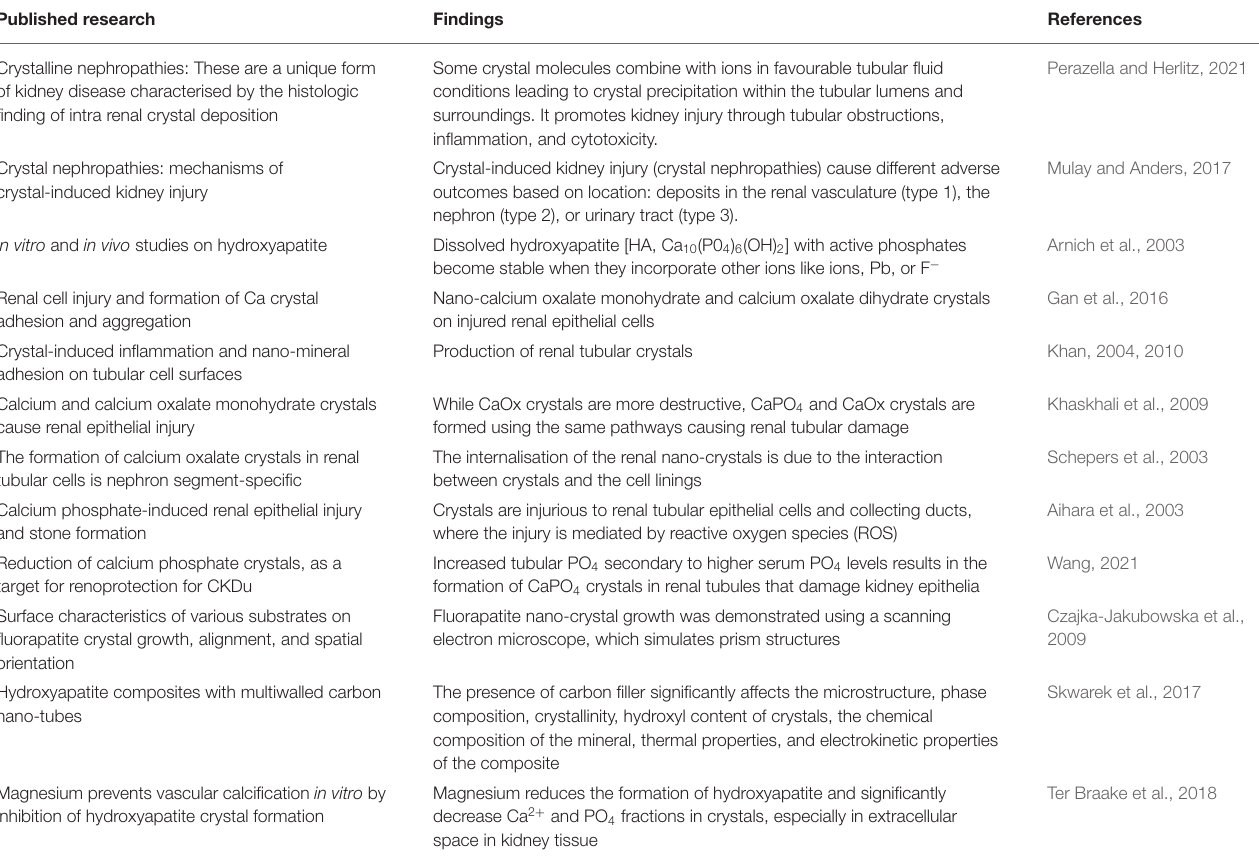
TABLE 1 | Few published examples of nano-crystal formation in human renal